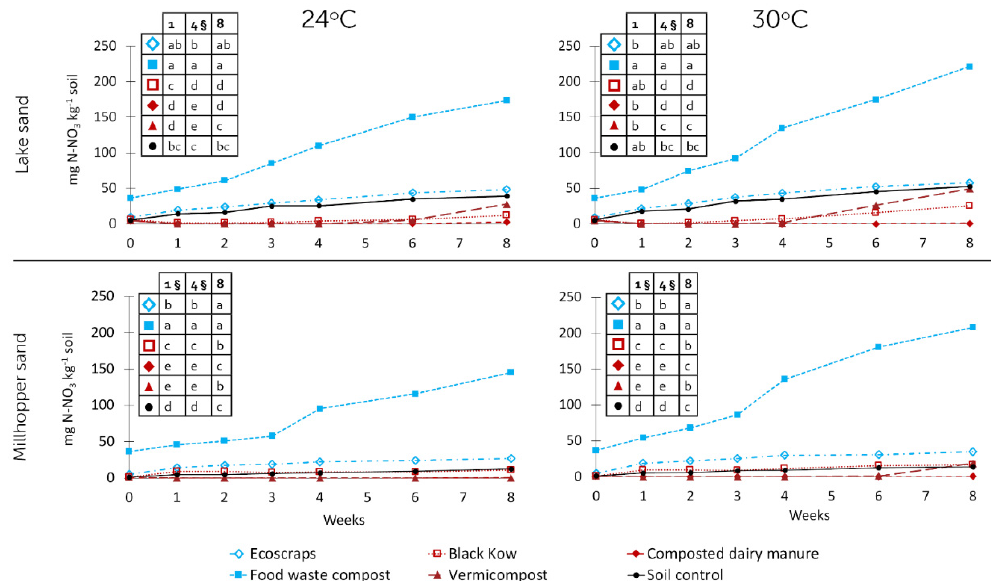
Figure 2. Mean N-NO 3 kg − 1 soil measured at weeks 0, 1, 2, 3, 4, 6, and 8 (SEs were always <8.1). In-